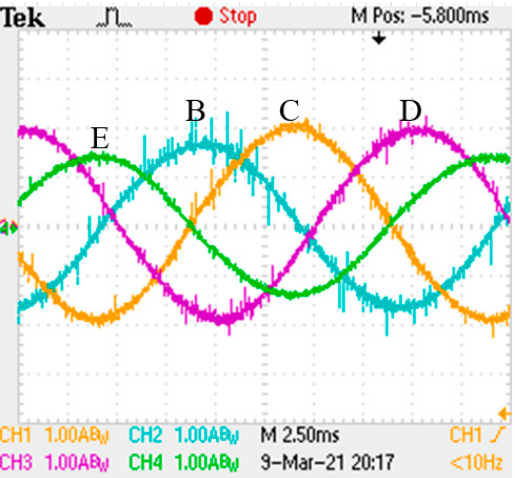
Figure 11. Waveform diagram of the lack of phase A current experiment.